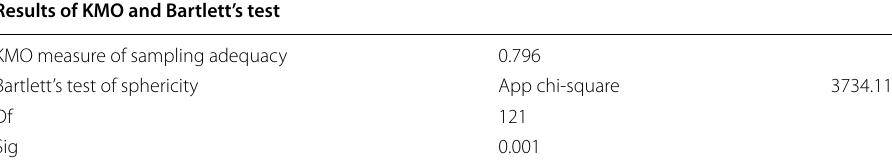
Table 3 Assumptions of factorability Results of KMO and Bartlett’s